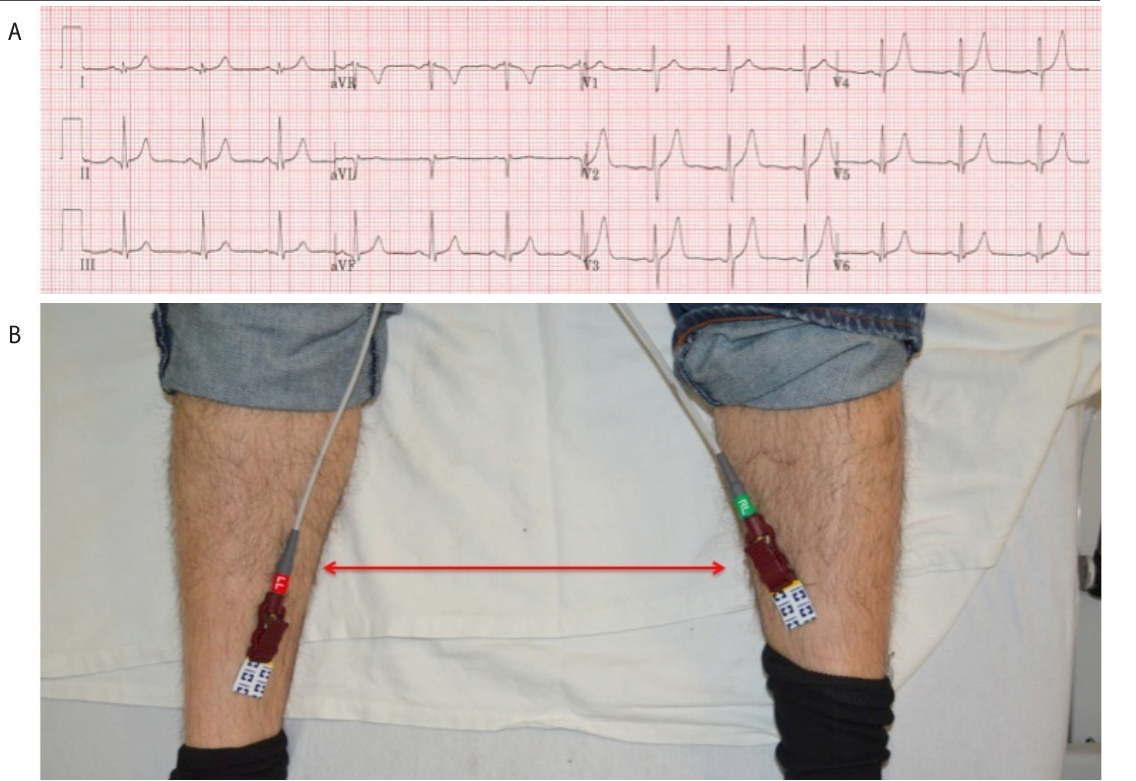
Figure 3. 12 lead ECG depicting left leg and right leg reversal. (A) ECG recording. (B) Arrows point to reversal of leads on left leg and right